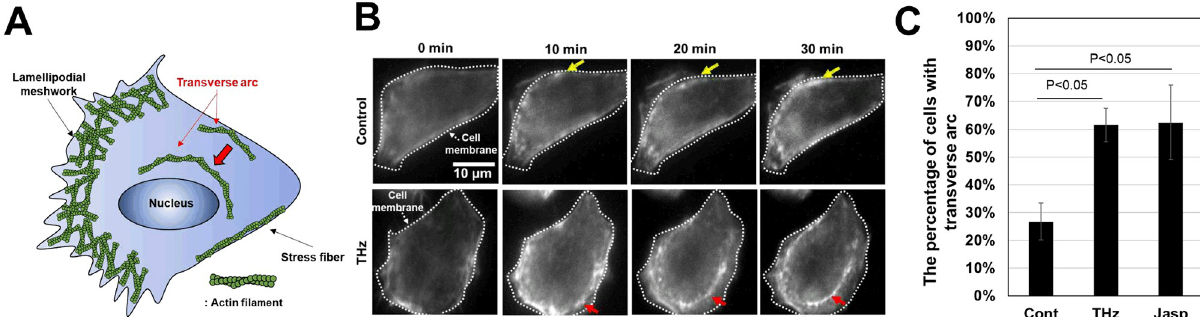
Fig 5. Effect of THz irradiation on actin-including structures. (A) Illustration of the functional structures that include actin filaments inside cells. In the cytoplasm, actin filaments form massive assemblies, which can be categorized as stress fibers, lamellipodial meshworks, and transverse arcs. Stress fibers are static structures that exist along the cell membrane; the lamellipodial meshwork is observed in the leading edge of the cell; and transverse arcs are generated in the cell membrane and move to the center of the cell. (B) Live-cell imaging of actin filaments with and without THz irradiation. The white dotted line marks the cell membrane. The yellow arrow shows stress fibers, which appeared along the cell membrane. The red arrow shows a transverse arc, which was generated in the cell membrane and moved to the center of the cell for 20–30 minutes. The scale bar represents 10 μ m. (C) Percentage of cells, in which transverse arcs appeared during microscopy observation for 30 minutes. As a positive control, cells were treated with 10 nM jasplakinolide at 0 minutes to induce actin polymerization. The error bar shows the standard deviation of three independent experiments. More than 184 cells were measured in each